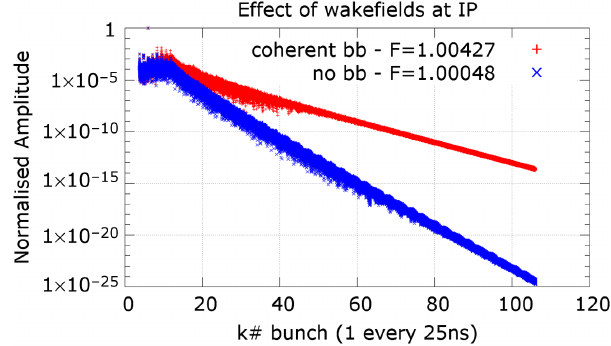
indicated).FIG. 13. Normalized actions of the bunches at the IP. Only the bunch with action 1 carries an initial misalignment. All other bunches are excited by LRWs. Each bunch contains 4 × 10 9